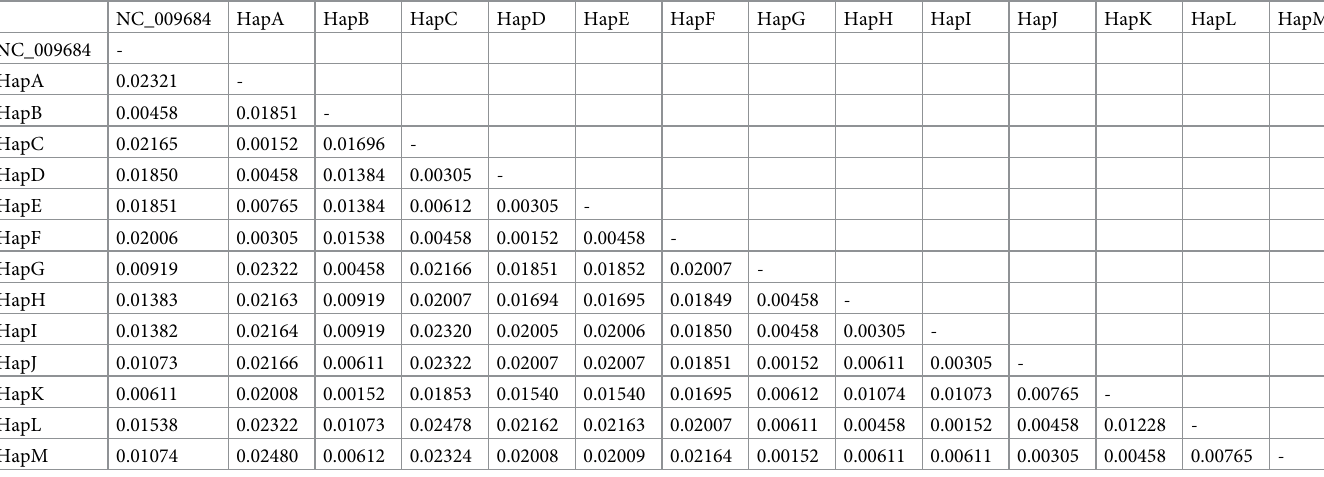
Table 2. Pairwise genetic distance among different haplotypes of ALD and between different haplotypes of ALD with reference